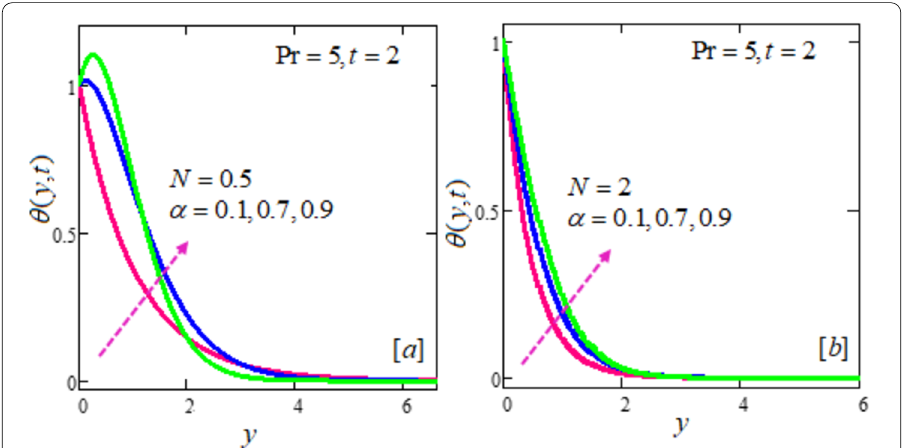
Figure 2 Temperature profile variation with fractional parameter α and radiation parameter